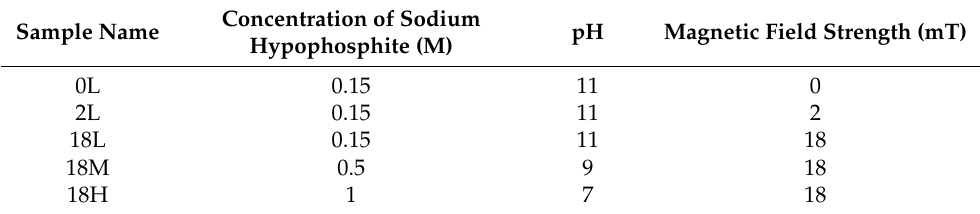
Table 1. Preparation conditions of nickel phosphide